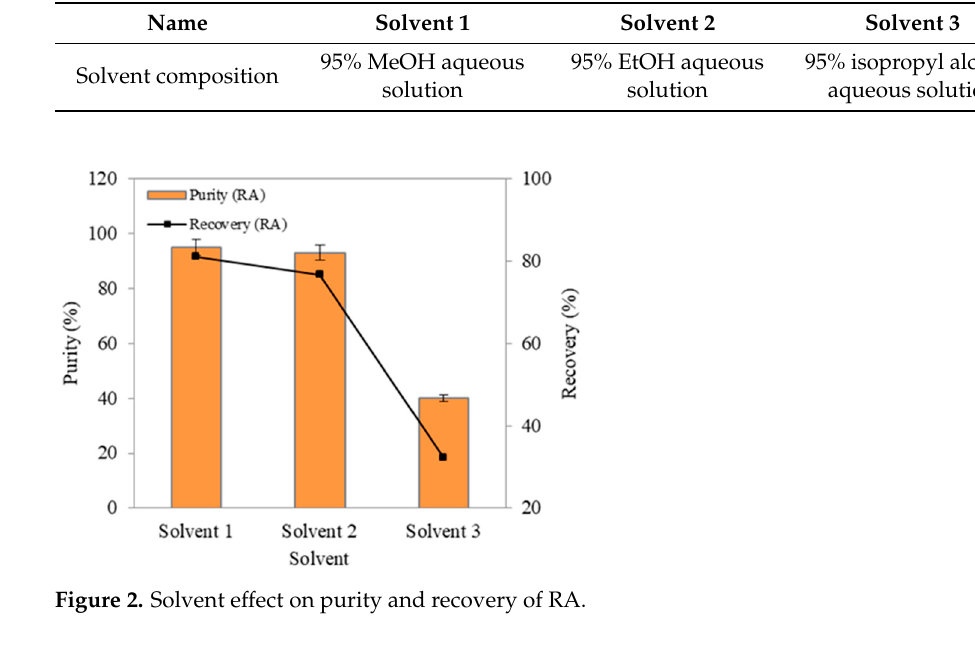
( d ) Figure 3. Effect of ( a ) MeOH concentration (16 h, 1:4 of the solid-liquid ratio, and 25 °C), ( b ) recrystallization time (90% of methanol concentration, 1:4 of the solid-liquid ratio, and 25 °C), ( c ) solid-liquid ratio (90% of methanol concentration, 16